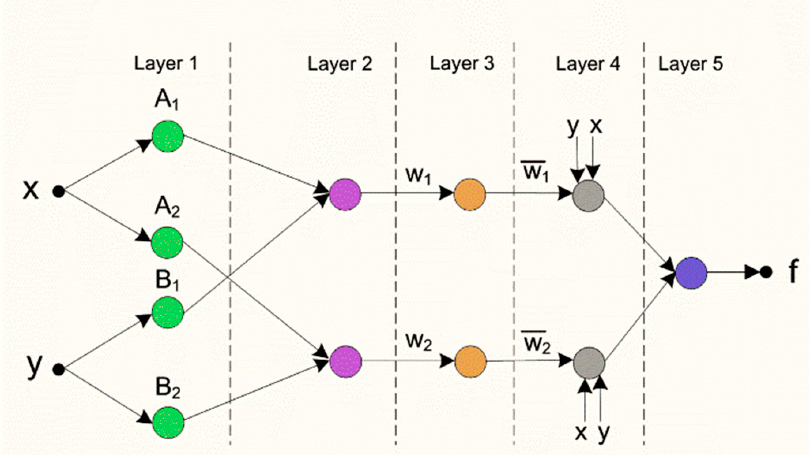
Figure 6. ANFIS structure.